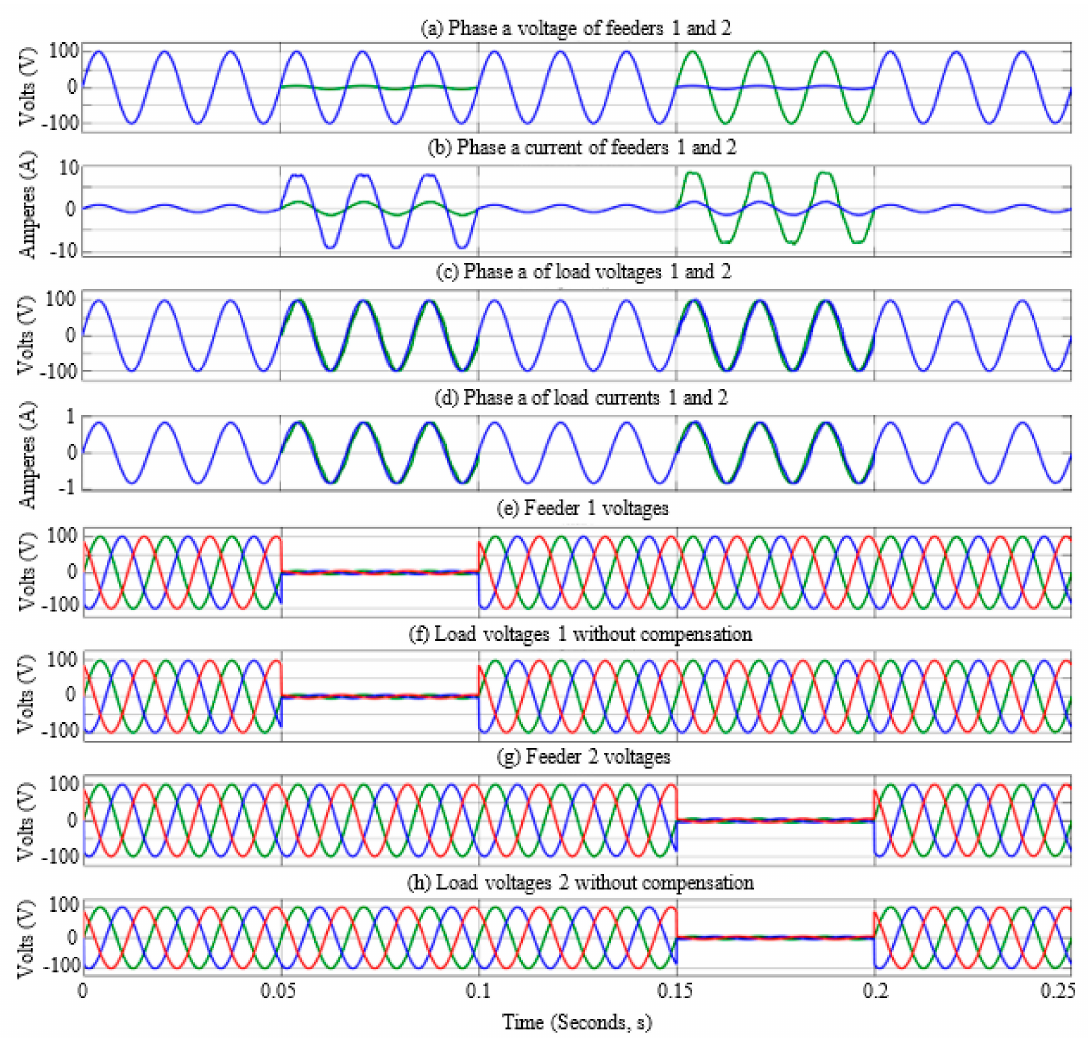
Figure 16. System waveforms in the voltage interruption compensation. ( a – d ) System phase a waveforms; ( e – h ) system waveforms without